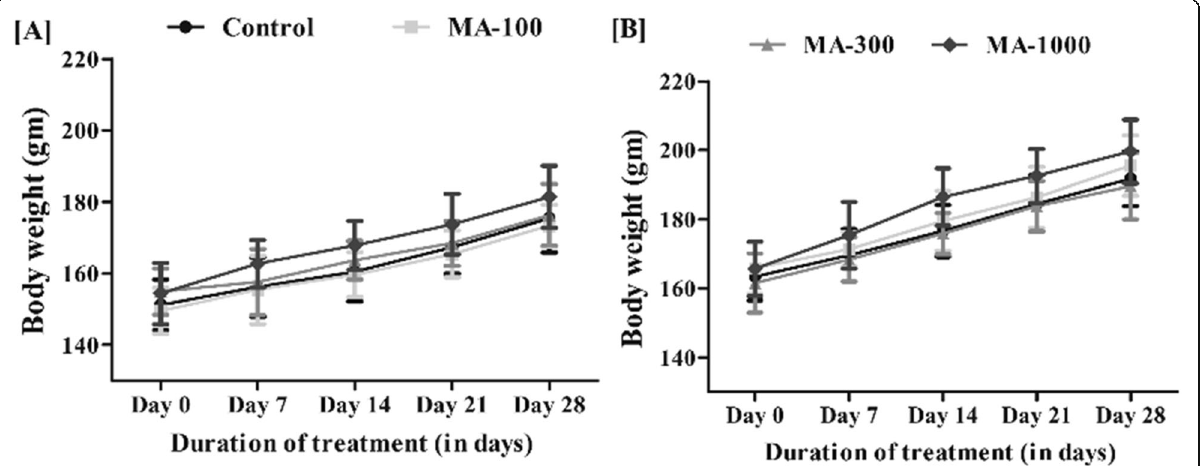
Fig. 5 Changes in body weight of rats treated with MA for a period of 28 days. a Male rats and b female rats. The values were presented as mean ± SD